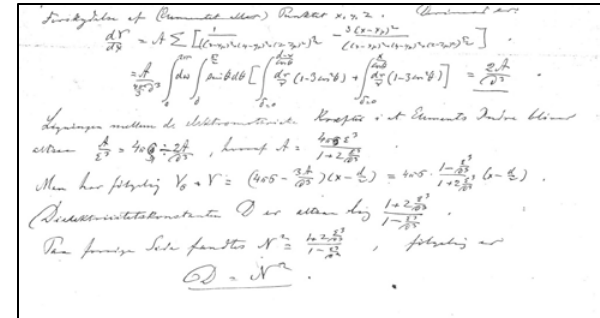
Figure 7. Lorenz’s unpublished derivation of the relationship between the dielectric constant (D) and the specific refractivity